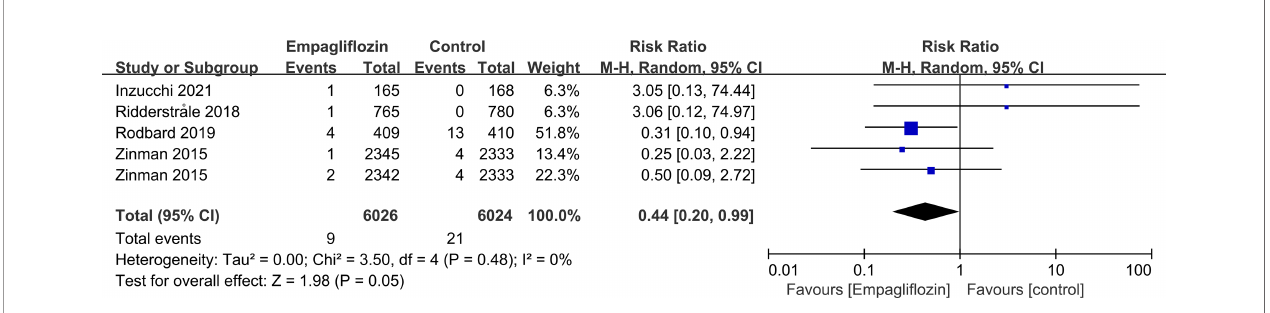
FIGURE 7 | Effect of empagli fl ozin on incidences of DR compared with control in T2DM patients.